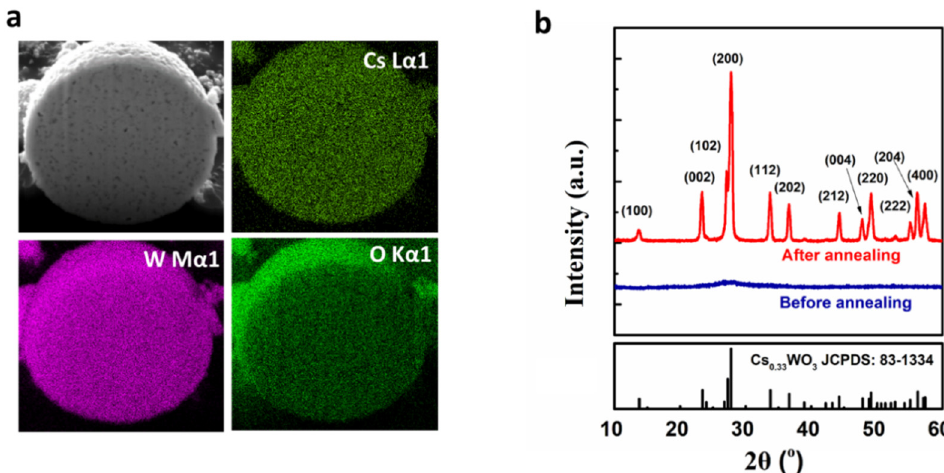
Figure 3. Elemental and structural analysis of Cs 0.33 WO 3 : ( a ) focused ion beam (FIB)-cut cross image and EDS mapping of Cs, W, and O elements and ( b ) XRD patterns of Cs 0.33 WO 3 before and after annealing.